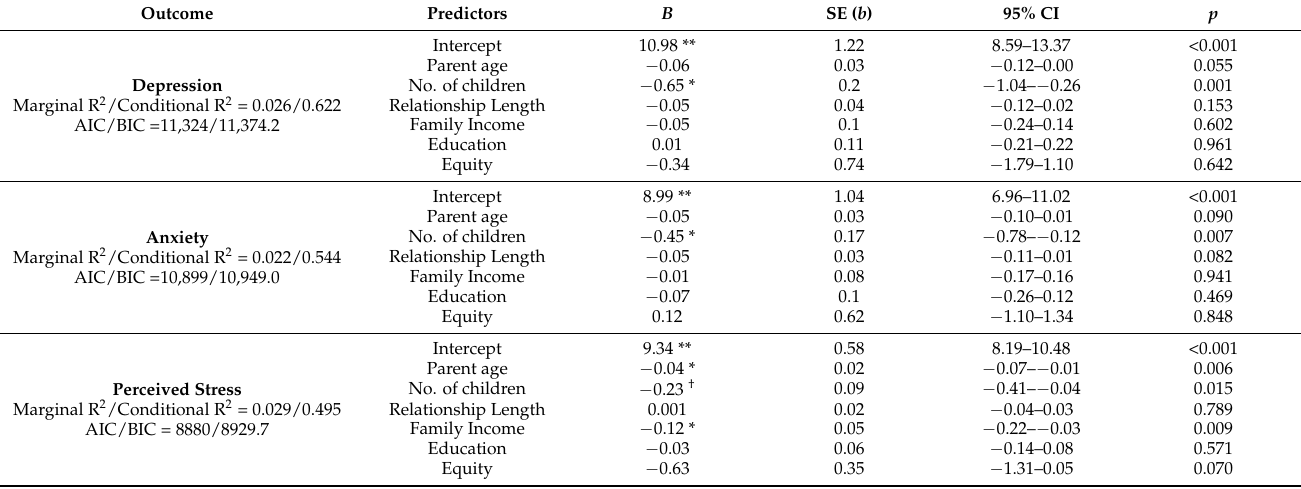
Table 4. Effects of equity on parents’